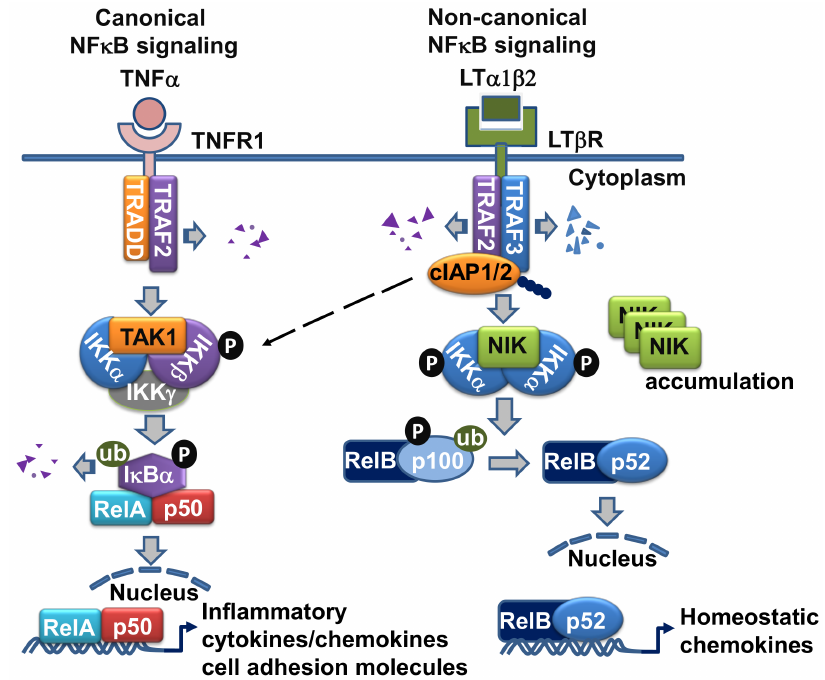
Figure 2. The LT β R signaling pathway in lymphatic endothelial cell (LEC). LT α 1 β 2 engagement of LT β R initiates the recruitment of TRAF2 and TRAF3 to the LT β R complex, where TRAF2 and TRAF3 are degraded by cIAP1/2, and result in NF- κ B-inducing kinase (NIK) stabilization and accumulation. NIK complexed with IKK α is activated and leads to the homodimeric IKK α phosphorylation. Even- tually, the p100 precursor binding with RelB is cleaved to p52 and causes RelB-p52 heterodimeric complex translocation to the nucleus to initiate chemokine gene transcription. LT β R ligation also activates IKK α / β phosphorylation and RelA/p50 nuclear translocation, which leads to gene tran- scription of inflammatory and cell adhesion molecules. TRAF-2-mediated K63 ubiquitination of cIAP1/2 is also linked to the activation of canonical NF κ B